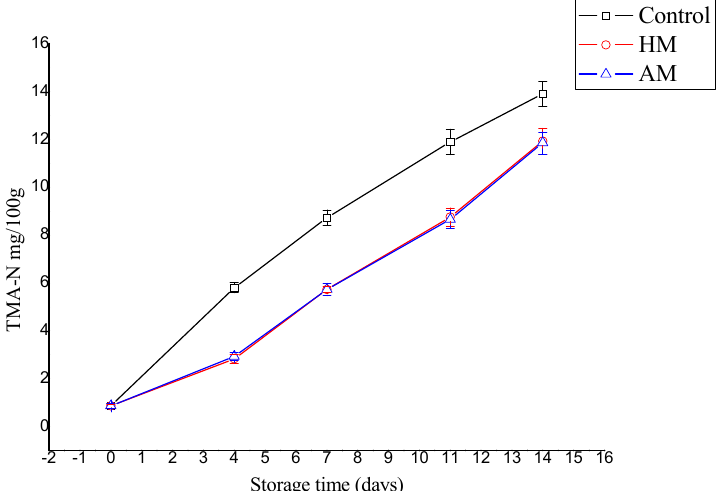
Figure 2. Evaluation of trimethylamine (TMA-N) content in control, Hypnea musciformis (HM), and Acanthophora muscoides (AM) treated shrimp muscle relative to days of storage at 0 °C ( n = 3, average ± standard deviation) .